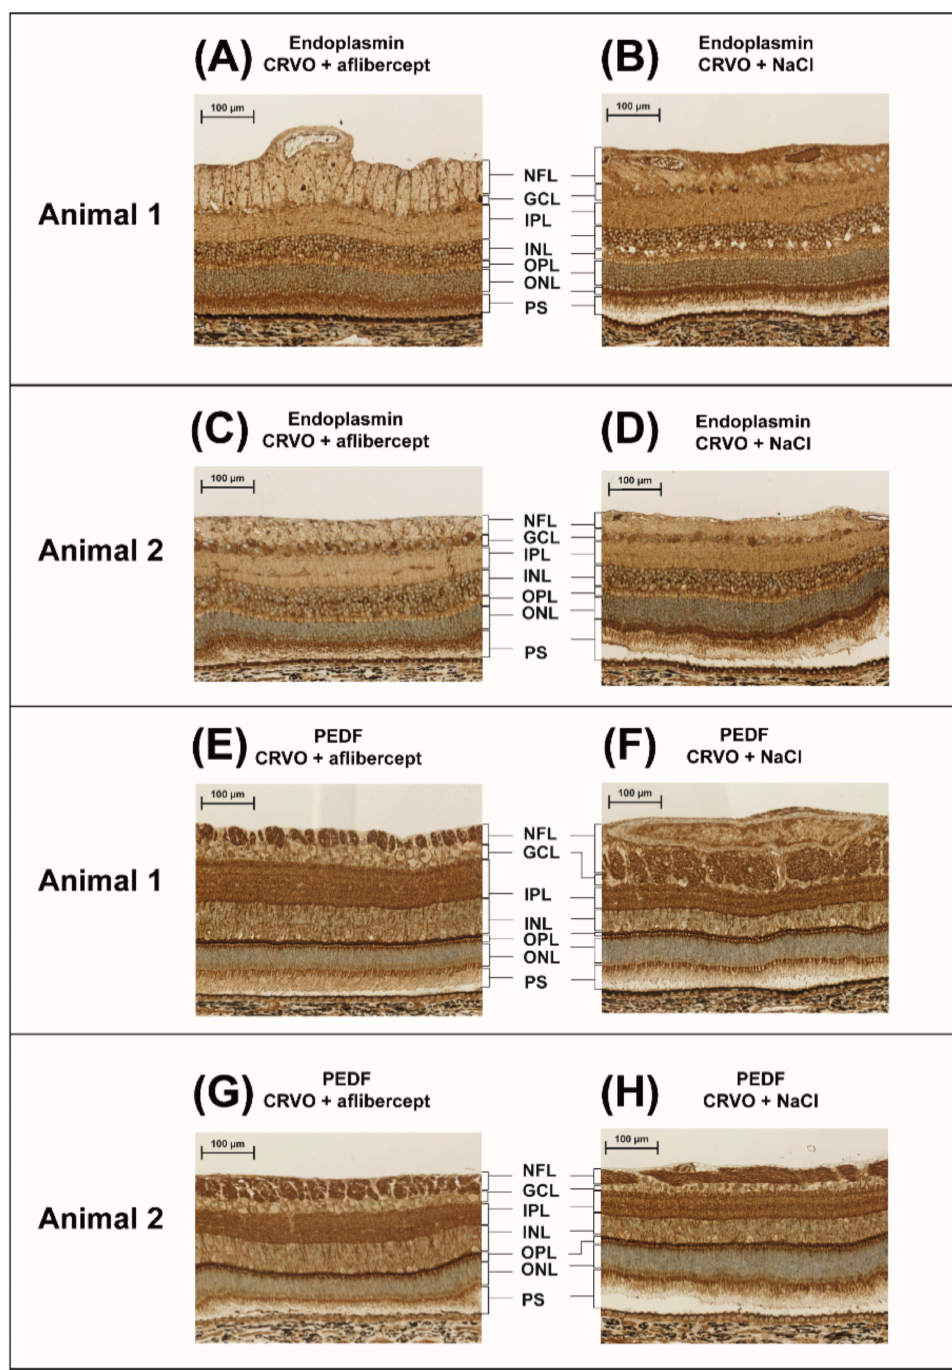
Figure 5. Immunohistochemistry comparing CRVO + aflibercept vs. CRVO + NaCl. Proteome analysis showed a small downregulation of endoplasmin and PEDF, which was further explored with immunohistochemistry. Immunohistochemistry showed similar staining patterns of ( A – D ) en- doplasmin and ( E – H ) PEDF regardless of aflibercept intervention. Thus, immunohistochemistry of retinas treated with aflibercept did not show major changes in regulation of the endoplasmin or PEDF in specific retinal layers. Scale bar = 100 µ m. Reaction color: brown. Abbreviations: NFL: nerve fiber layer; GCL: ganglion cell layer; IPL: inner plexiform layer; INL: inner nuclear layer; OPL: outer plexiform layer; ONL: outer nuclear layer; PS: photoreceptor